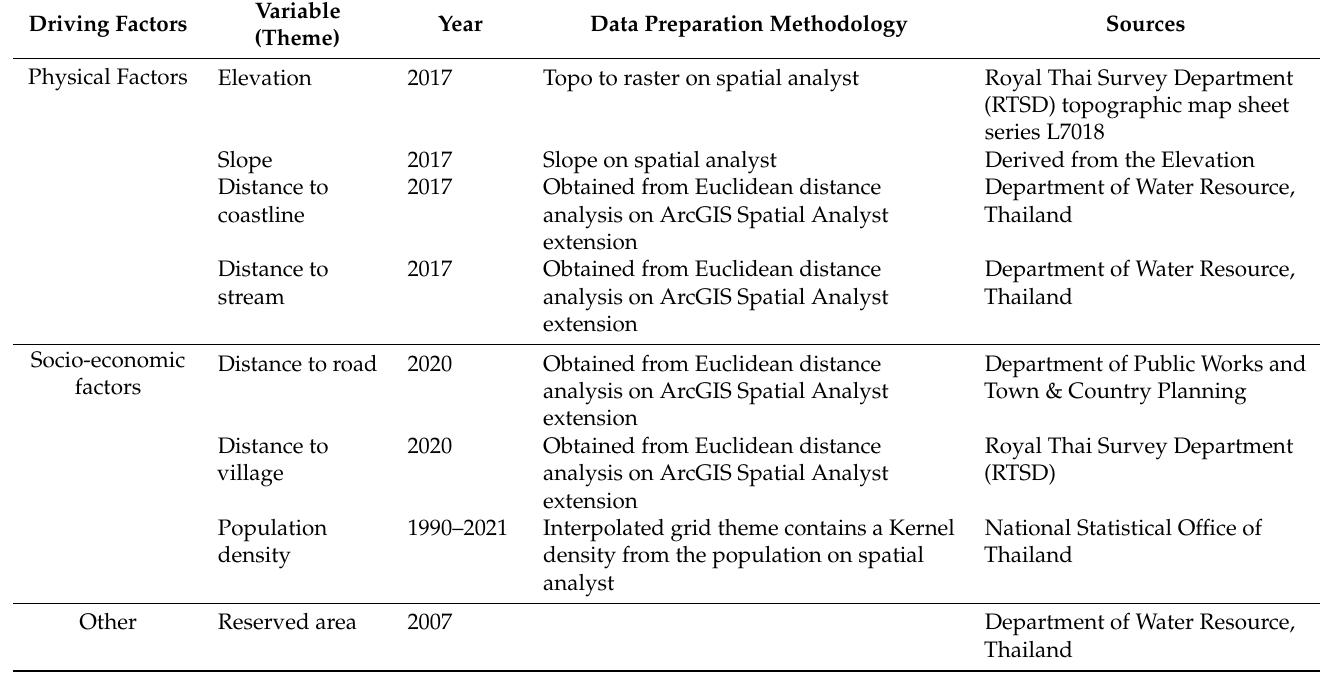
Table 2. Geo-spatial data (physical factors and socio-economic